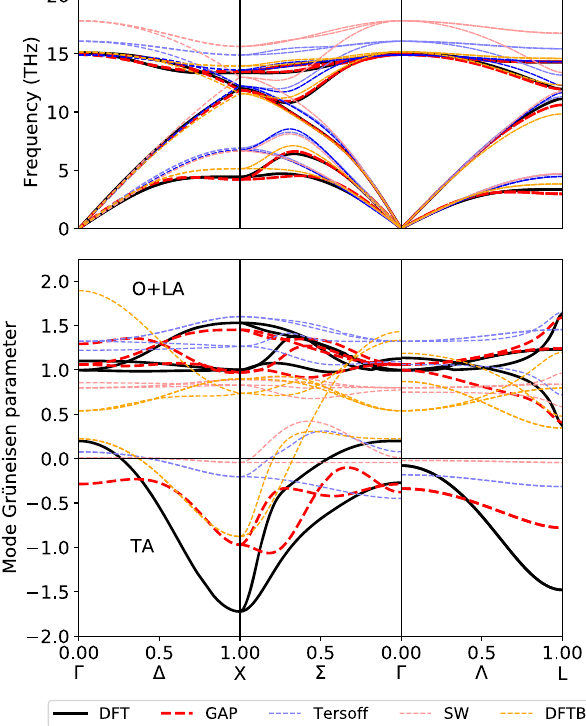
FIG. 19. Top: Phonon dispersion curves of cubic diamond silicon at 0 GPa with various models. Bottom: Dispersion curves of mode Grüneisen parameters.